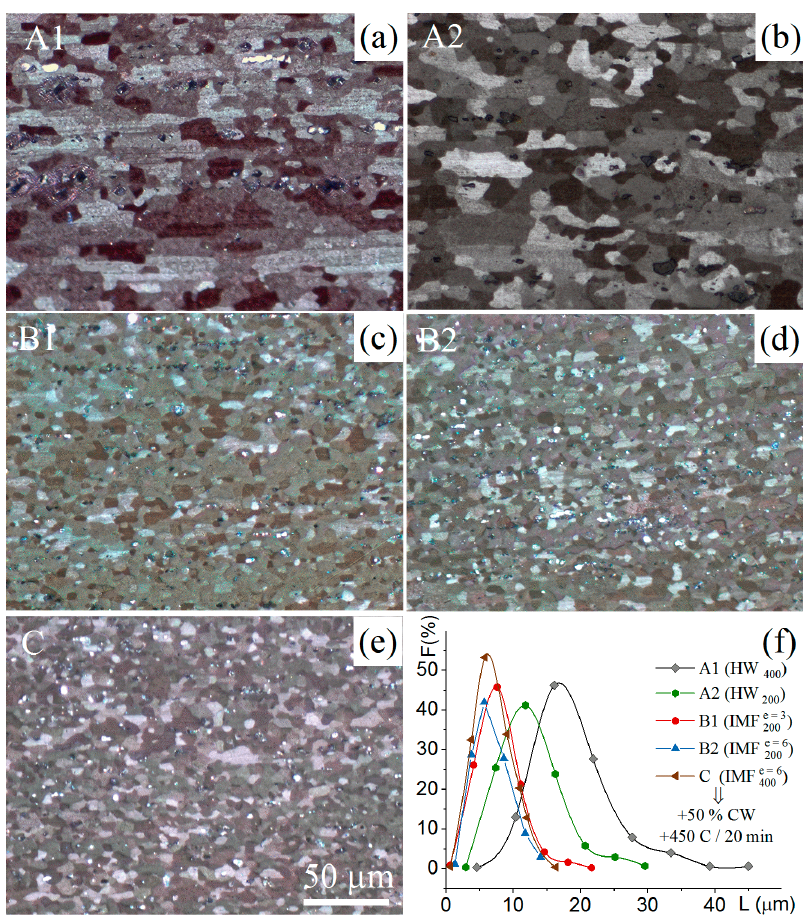
Figure 10. The microstructures of cold-rolled sheets after annealing at 450 ° С for 20 min for ( a ) A1, ( b ) A2, ( c ) B1, ( d ) B2, and ( e ) C treatment modes and ( f ) frequency ( F ) vs grain size ( L ) for studied treatments modes.